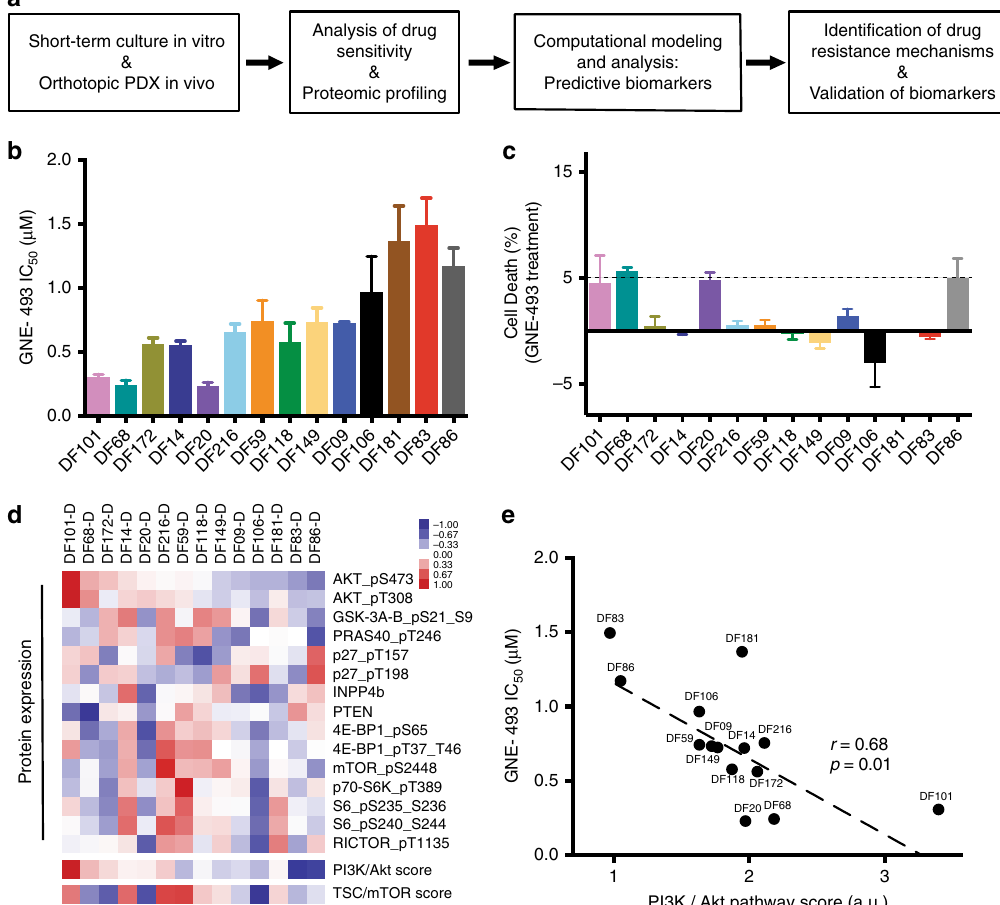
Fig. 1 Analysis of PI3K/AKT/mTOR pathway activation at the protein level and sensitivity to PI3K/mTOR inhibition. a A systems approach strategy using a panel of 14 HGS-OvCa PDX and integrated drug pro fi ling/proteomics to identify drug resistance mechanisms and validate response biomarkers. b PI3K/ mTOR inhibitor (GNE-493) IC 50 values ranked according to PI3K/AKT activation status (phospho-AKT S473 protein levels). Data is derived from three independent experiments and error bars denote SEM. c cell death after PI3K/mTOR treatment (GNE-493 0.3 μ M, 96 h) using laser scanning cytometry. Data is representative of three independent experiments. Error bars represent SEM for n = 6 replicate wells. d Heatmap showing protein levels (median- centered) of PI3K/AKT/mTOR pathway targets for PDX samples under short-term in vitro culture conditions. Samples ranked according to PI3K/AKT activation status (data is representative of two independent experiments). e Correlation analysis of GNE-493 IC 50 values with PI3K/AKT pathway score (Pearson r = 0.68, p =